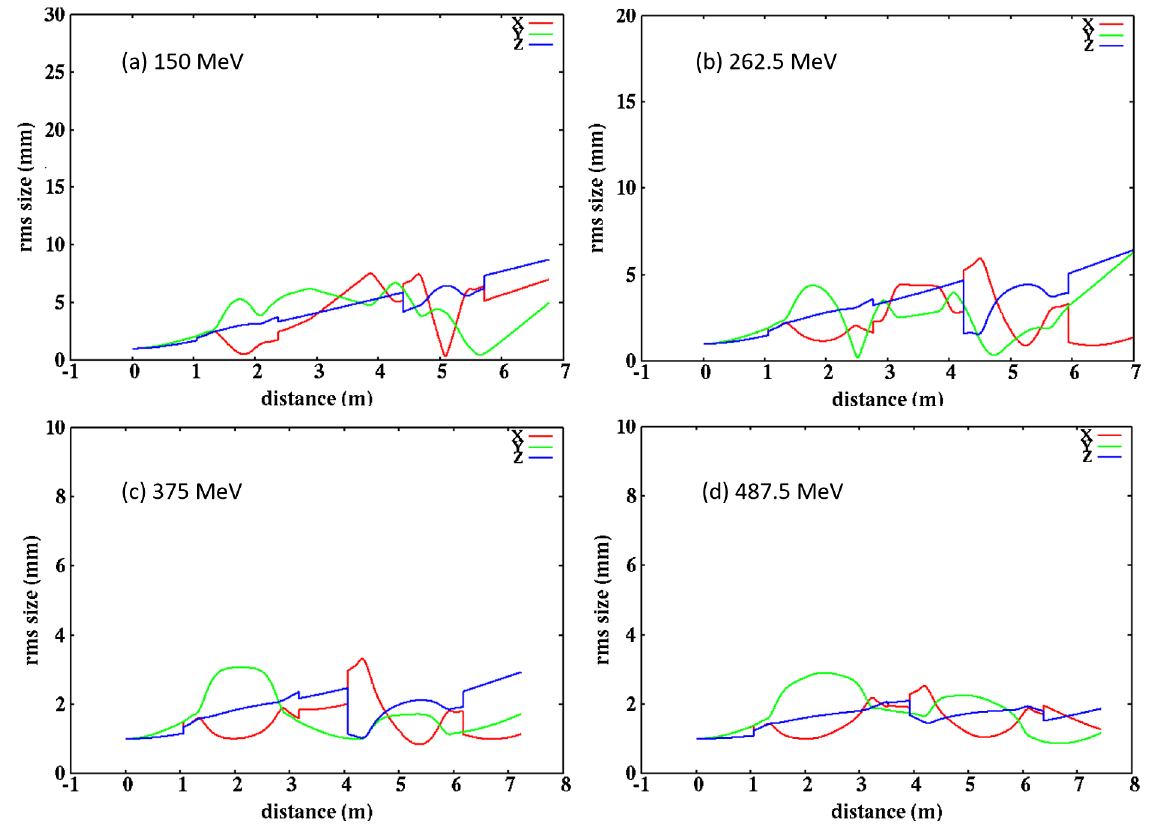
FIG. 12. Proton beam transverse and longitudinal RMS size evolution through the phase shifter (Table II) with 150 MeV (top left), 262.5 MeV (top right), 375 MeV (bottom left), 487.5 MeV (bottom right) kinetic energy, initial Waterbag distribution, and 40 mA current.